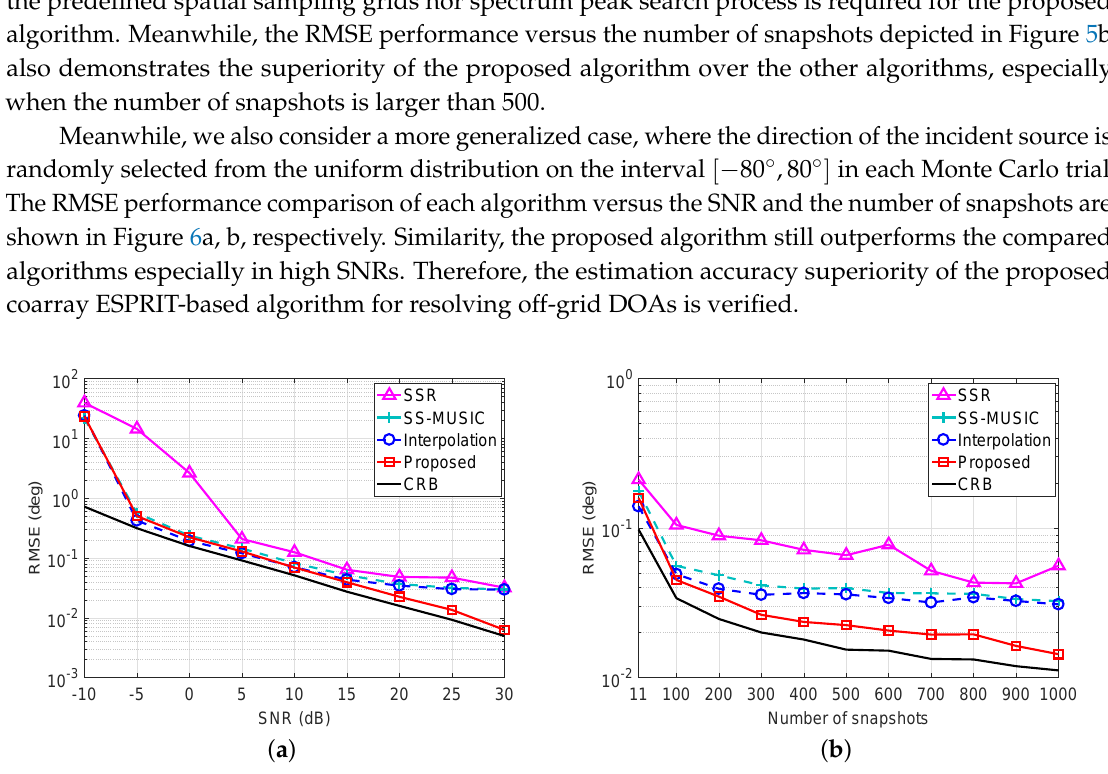
Figure 6. RMSE performance comparison with a single source, whose direction is randomly selected from [ − 80 ◦ ,80 ◦ ] in each Monte Carlo trial. ( a ) RMSE versus SNR with L = 50; ( b ) RMSE versus the number of snapshots with SNR = 10